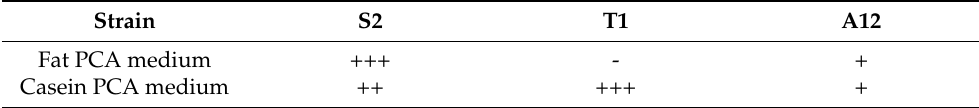
Table 2. Results of lipase and protease producing ability of strains. Strain S2 T1 A12 Fat PCA medium +++ - + Casein PCA medium ++